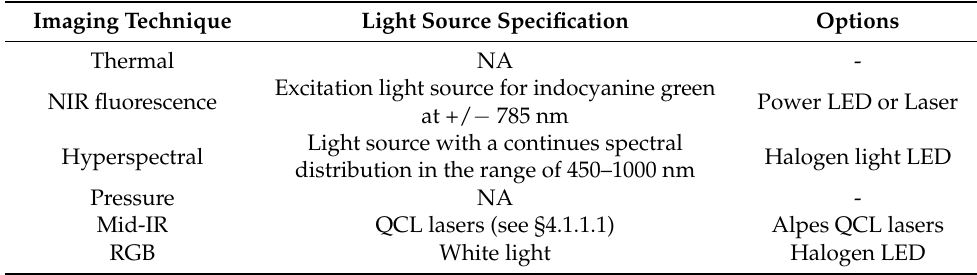
Table 3. Overview of light source specifications used for our sensors. Imaging